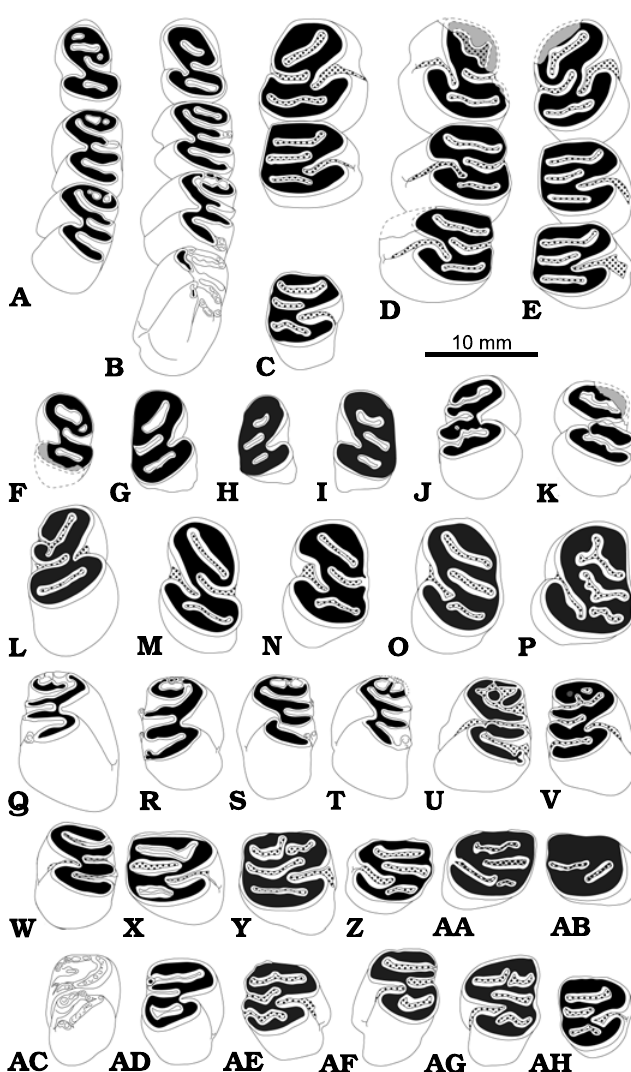
Fig. 5. Occlusal pattern of lower cheek teeth of the beaver Steneo fiber depe- reti Mayet, 1908, from the early Late Miocene locality Hammer schmiede (Bavaria, Germany), local stratigraphic levels HAM 5 and HAM 4.